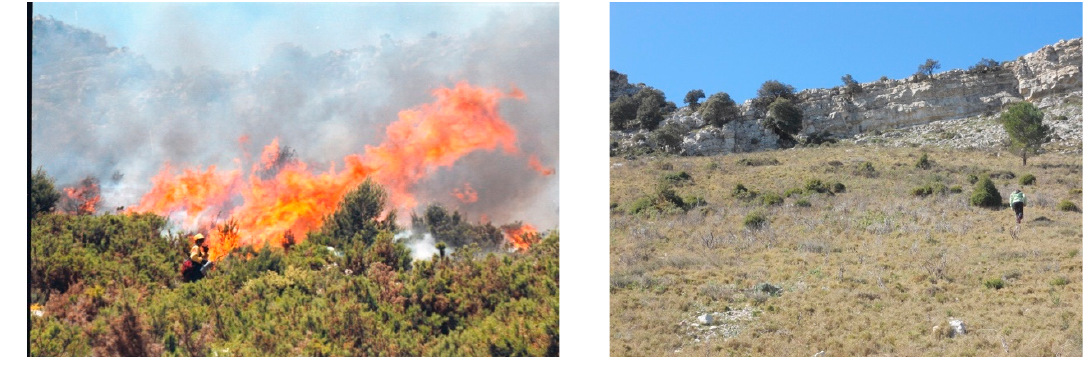
Figure 3. Tivissa plot during the first prescribed fire in 2006 (to the left, by Xavier Úbeda) and as seen nine years later during the most recent sampling event (to the right, by Meritxell Alcañiz).